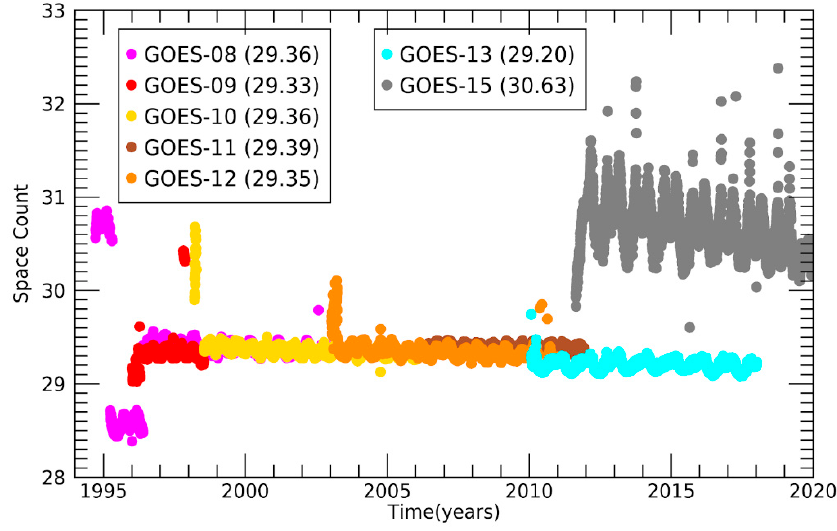
Figure 11. Time series of space counts from the GOES-IP sensors.